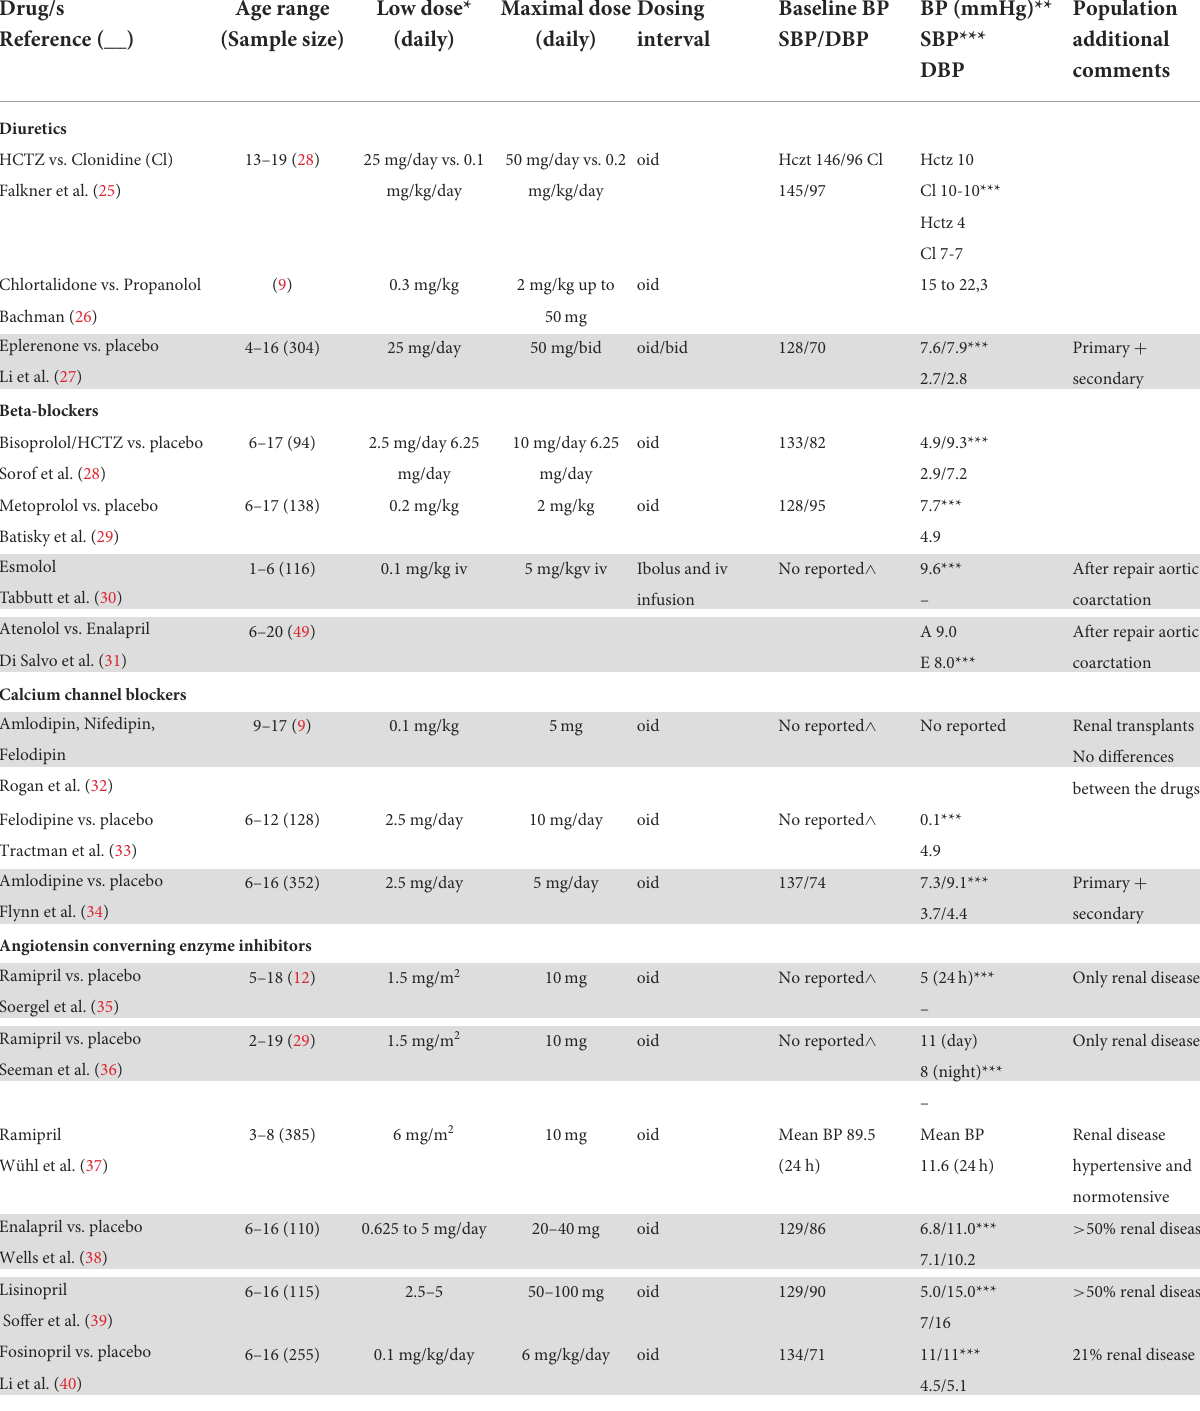
TABLE 3 Main characteristics of clinical trials in blood pressure